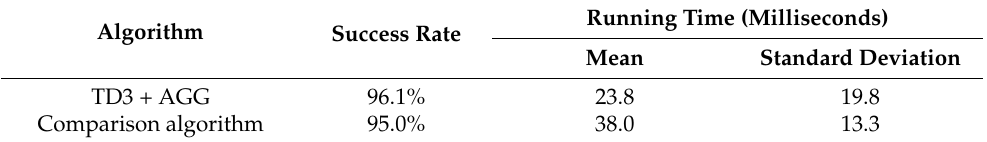
Table 4. Success rates and running times of TD3 + AGG and a nonlinear programming approach.